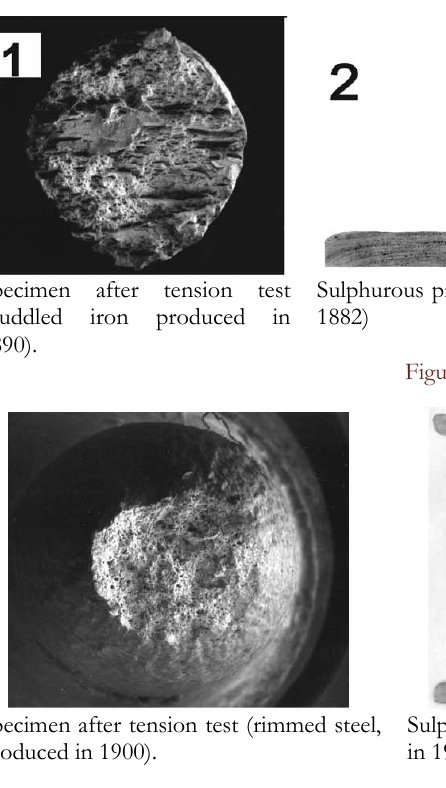
Figure 2: Characteristics of early mild iron (rimmed steel),